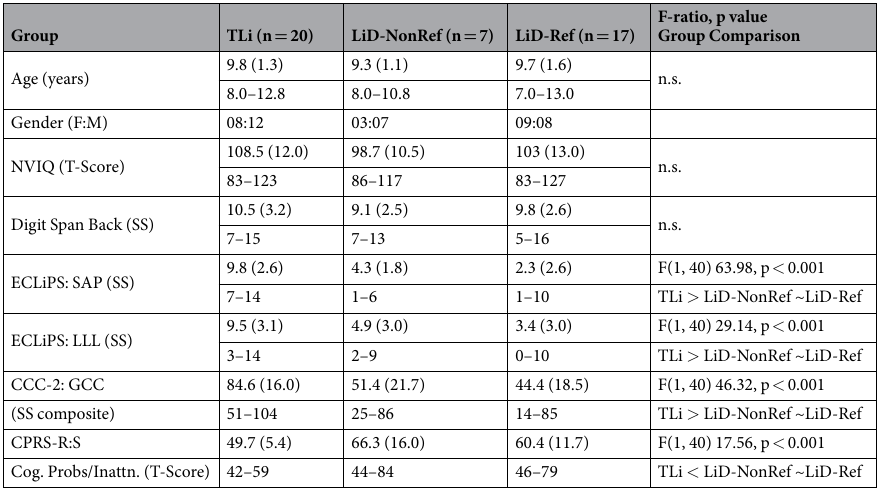
Table 1. Summary of the participants grouped according to listening ability, together with their respective scores on key behavioural and parental report measures (Mean (SD), Range). n.s. = non-significant. ECLiPS: SAP = Speech & Auditory Processing ; LLL = Language/Literacy/Laterality . CCC-2: GCC = General Communication Composite. Conners’ PRS-R:S Cog. Probs/Inattn. = Cognitive